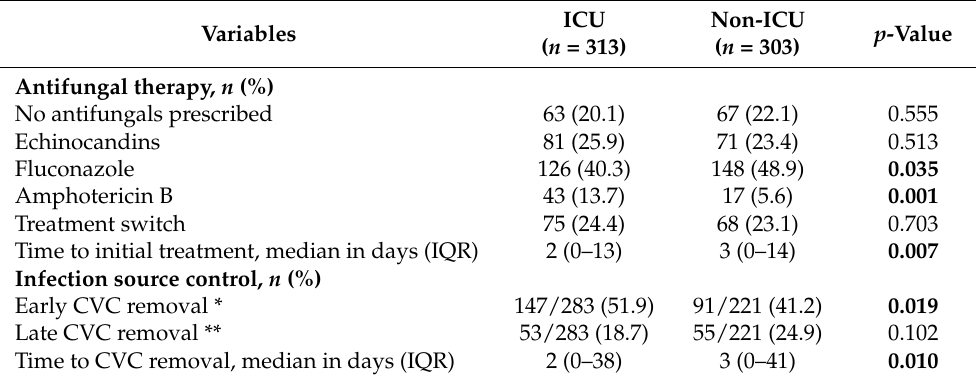
Table 4. Comparison of ICU vs. non-ICU therapeutic management of candidemia in 616 adult